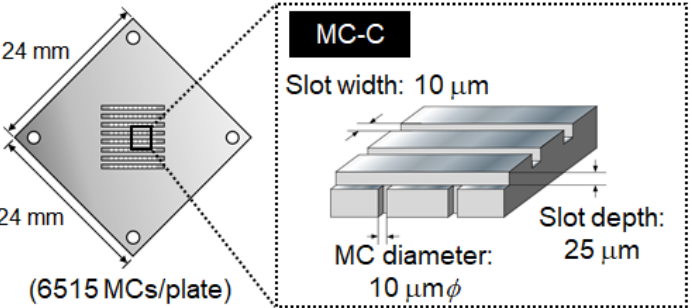
Figure 9. Schematic illustration and dimensions of MC plates used in this study.